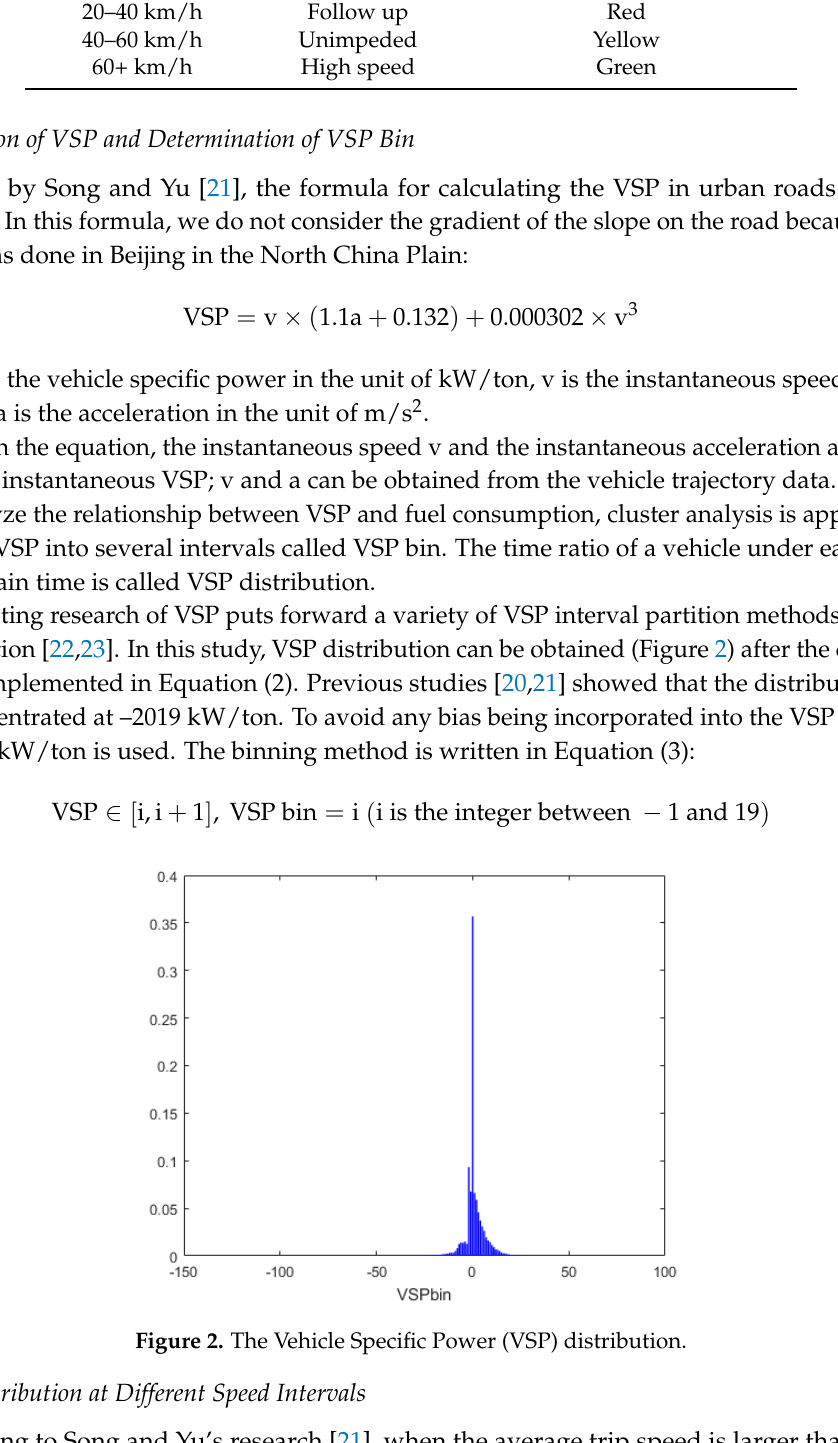
Table 4. The correspondences between the speed interval and traffic conditions prediction. Speed Interval Status The Color of Digital Map 0–20 km/h Idling Russetish 20–40 km/h Follow up Red 40–60 km/h Unimpeded Yellow 60+ km/h High speed Green